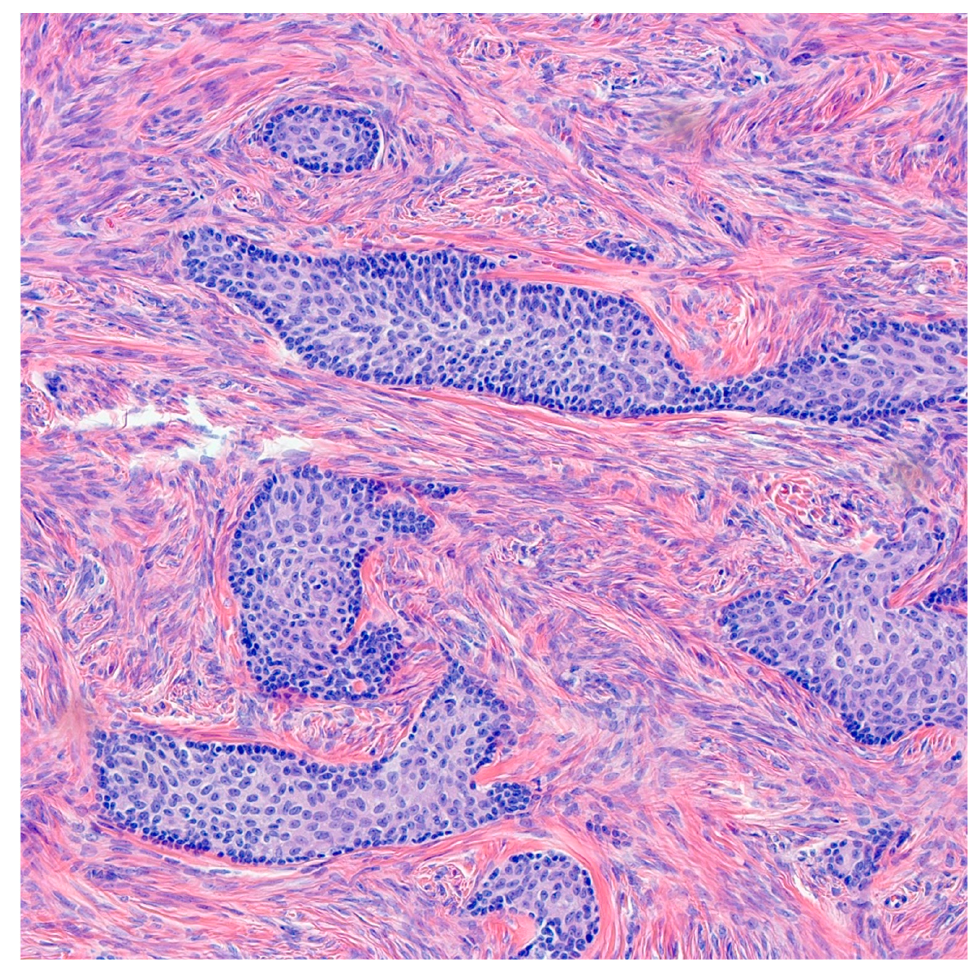
Figure 3. H&E microscopic image of benign Brenner tumor. Notice the nested architecture and the monotony of transitional epithelium. Additionally, note the dense fibromatous background (200× magnification).